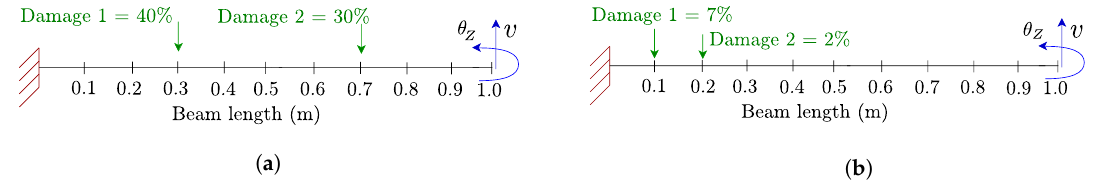
Figure 10. Double damage cases set in a 2D beam ( a ) at 0.3 m and 0.7 m with 40% and 30% stiffness reduction, ( b ) at 0.10 m and 0.20 m with 7% and 2% stiffness reduction,